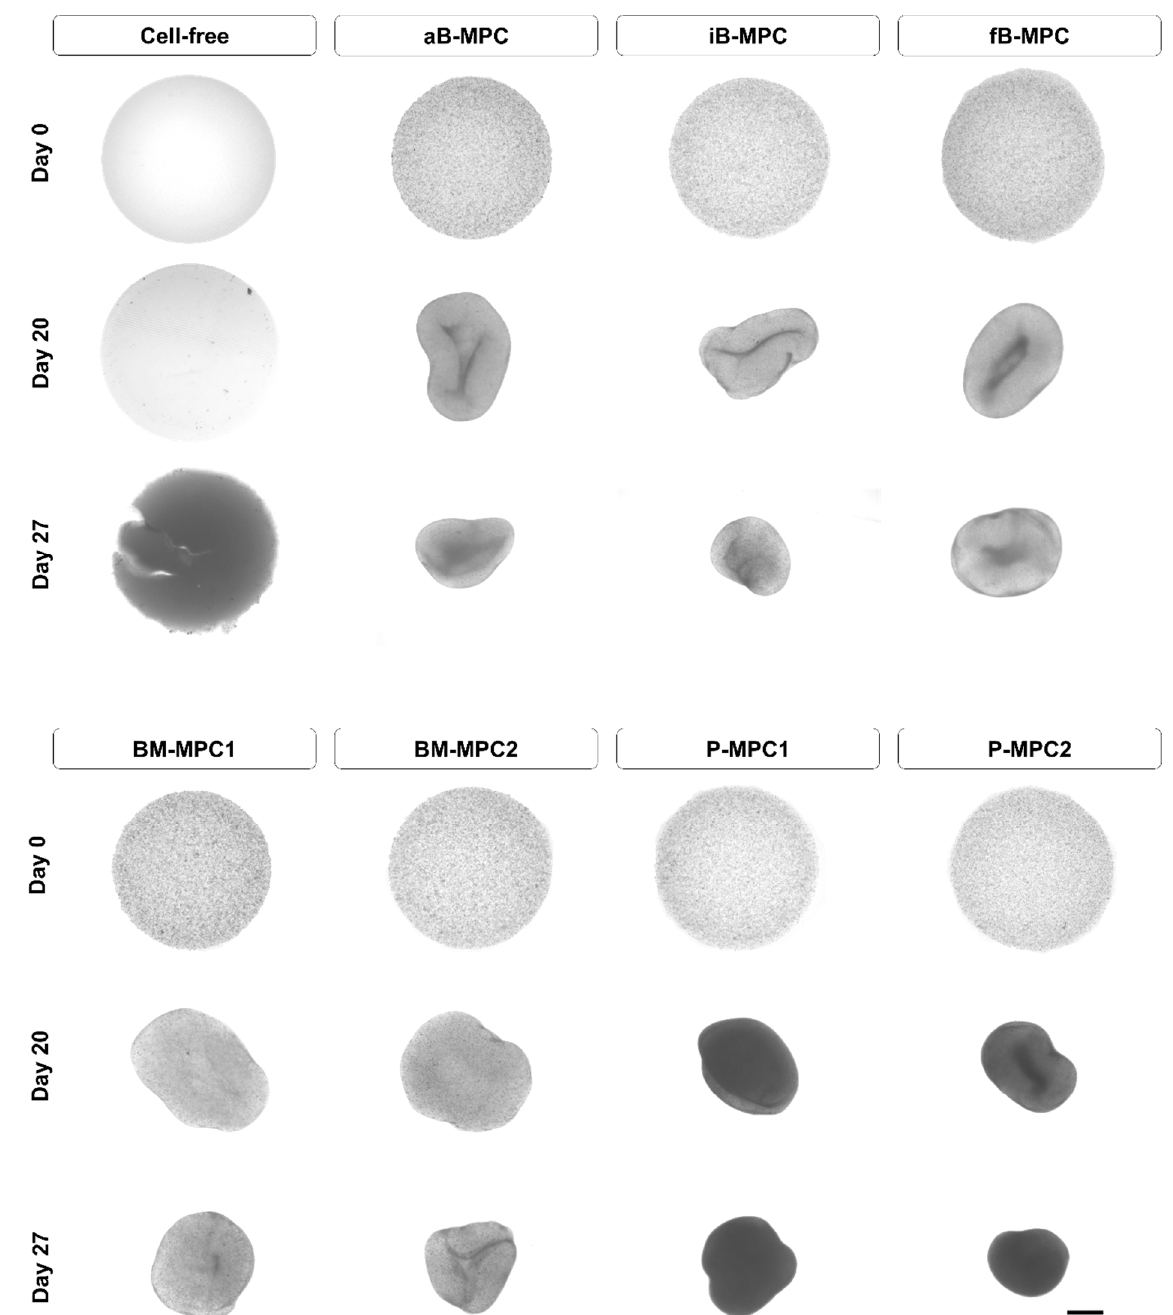
Figure 2. Cultivation of the printed constructs. Microscopic images were taken on days 0, 20, and 27 of cultivation. Scale bar = 1000 µm.